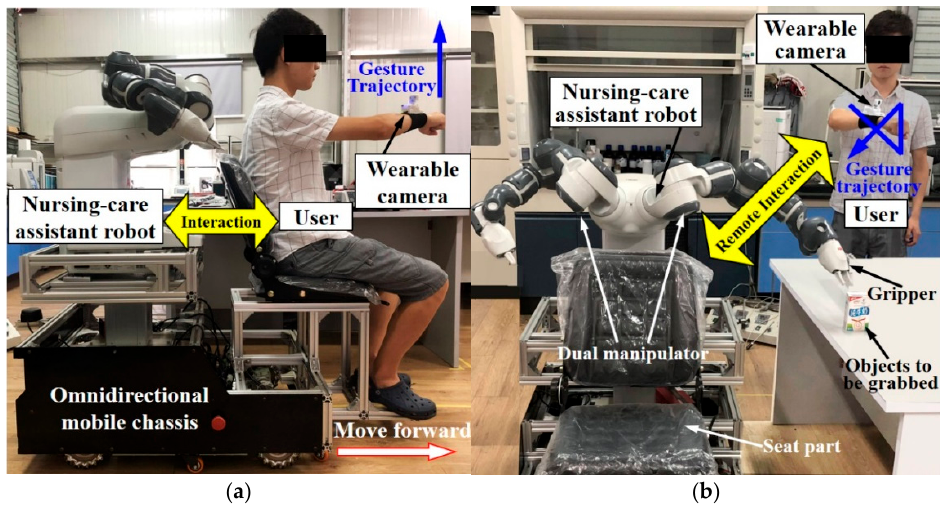
Figure 12. The implementation of the interaction with the nursing-care assistant robot: ( a ) Man-in-seat interaction mode of the nursing-care assistant robot; ( b ) Remote interaction mode of the nursing-care assistant robot.